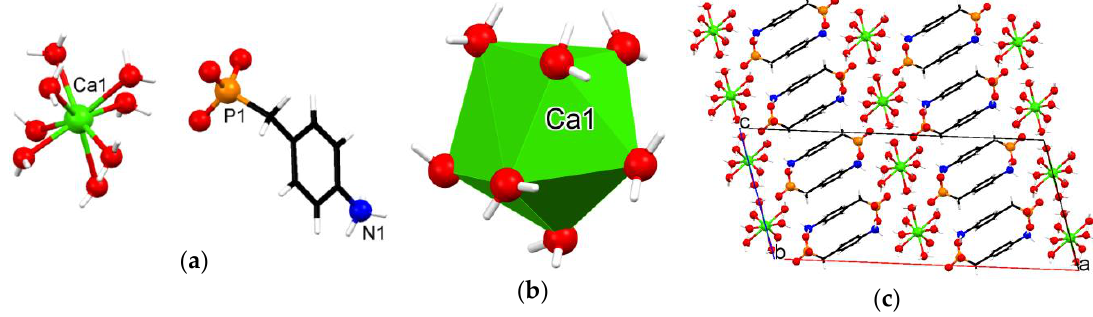
Figure 3. Crystal structure of Ca-PABPA: ( a ) View of the cation-anion pair; ( b ) The [Ca (H 2 O) 8 ] 2+ polyhedron; ( c ) Packing along the b axis.